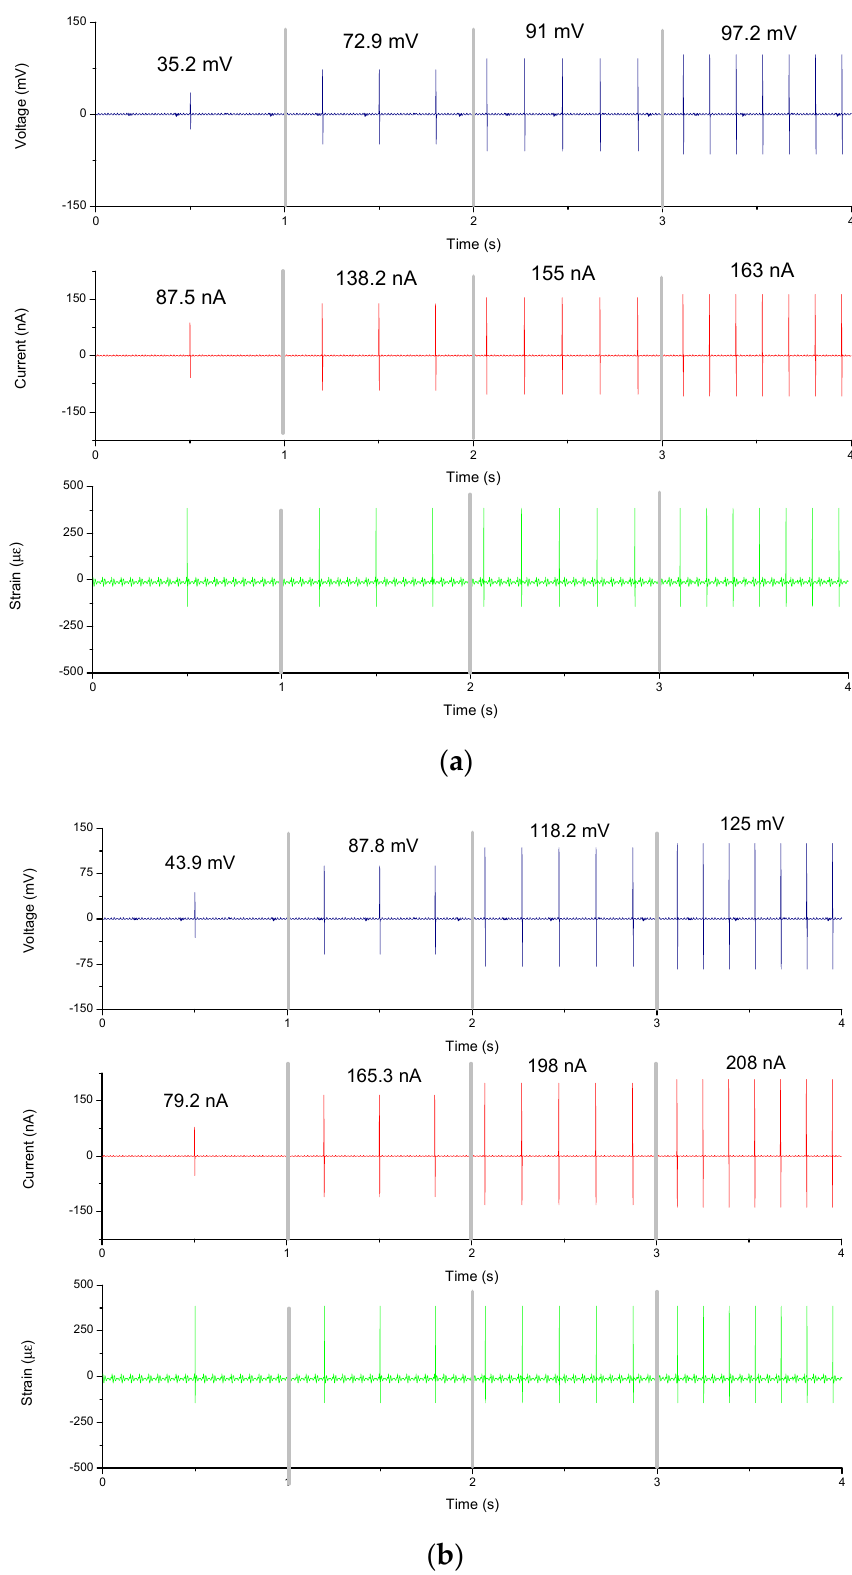
Figure 20. The electrical energy output results at different frequencies: ( a ) stepper motor electrospinning; ( b ) servo motor electrospinning.